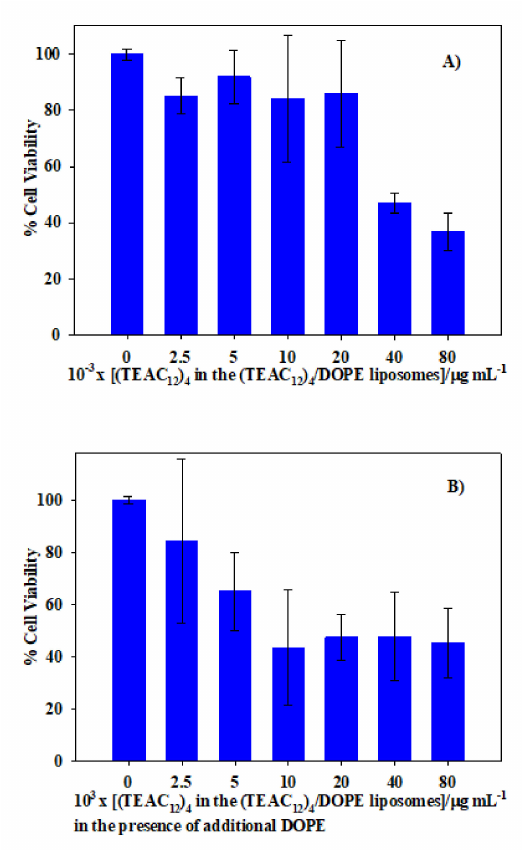
Figure 8. Dependence of the cell viability (%) of (TEAC 12 ) 4 /DOPE liposomes in U2OS cancer cell line, at 48 h, on the concentration of (TEAC 12 ) 4 within the liposomes, for a constant cationic lipid molar ratio α = 0.3. The experiments were done in triplicate. ( A ) In the absence of additional DOPE; ( B ) in the presence of additional DOPE (+ 1 / 4 of the DOPE amount present in the liposomes), which is not forming part of the (TEAC 12 ) 4 /DOPE